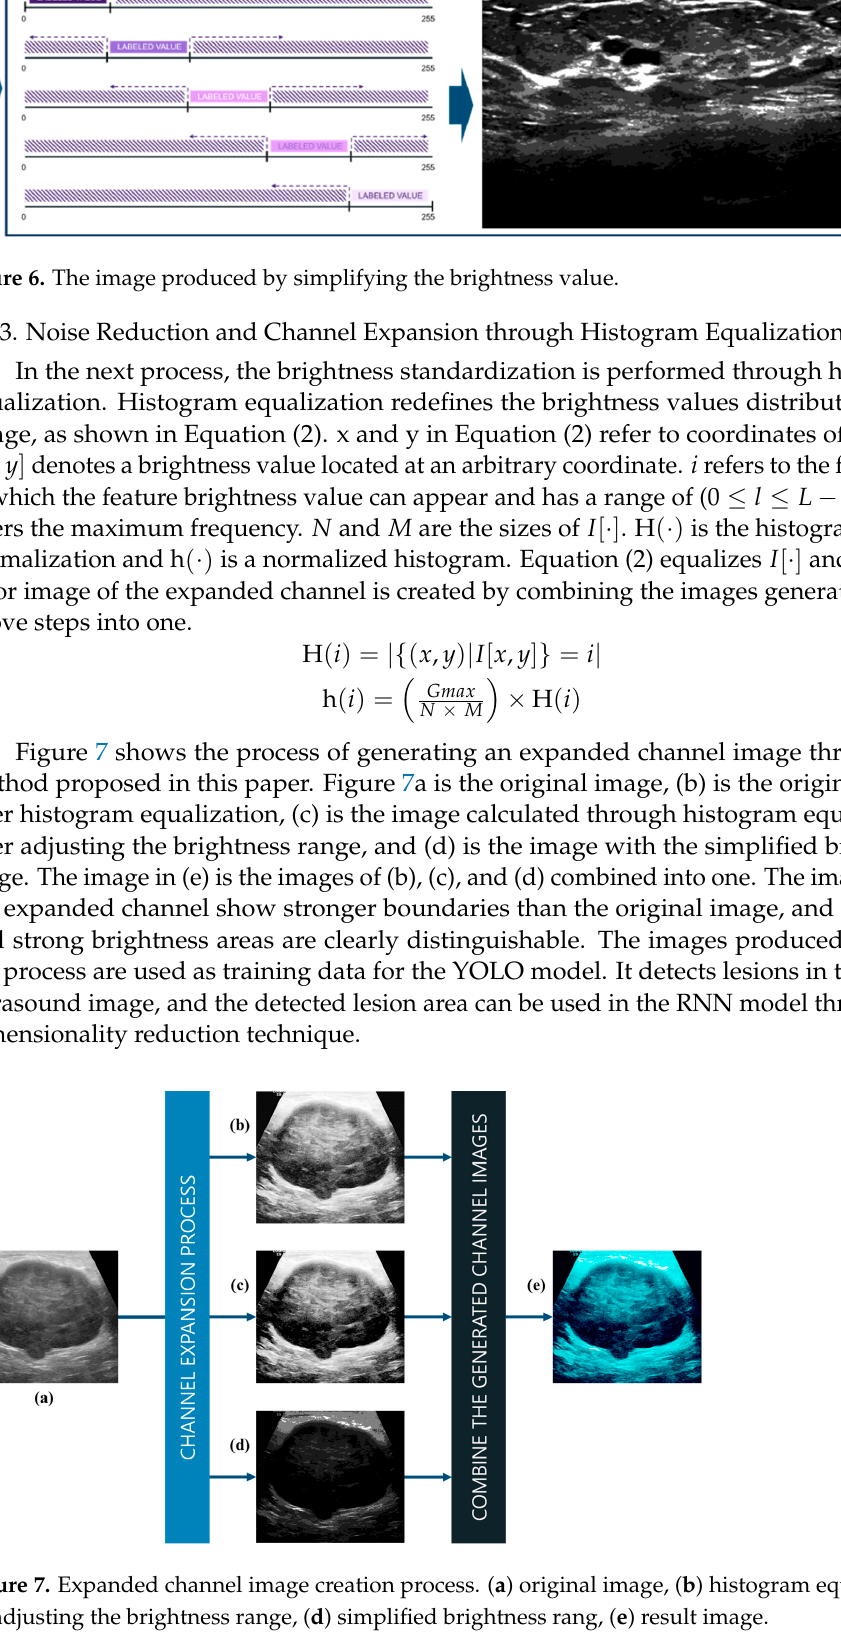
8 of 20 Algorithm 1 Brightness Spectrum Division Algorithm Input : x def Extraction of Feature: LABEL = [0,2,4,8,16] SPECTRUMAREA = 255// N for i from 0 to LEN(LABEL) do S = copy(x) S[SPECTRUMAREA ⅹ i > S] = 0 S[SPECTRUMAREA ⅹ (i+1) < S] = 0 S[S != 0] = LABEL[i] S = ((S/MAX(LABEL) ⅹ 255) Y += S Output: Y Figure 6 shows the image produced by simplifying the brightness value. It is the LABELING by classifying the image produced through brightness adjustment into SPECTRUMAREA. Each label consists of 0, 2, 4, 8, and 16, and they are the values set by the